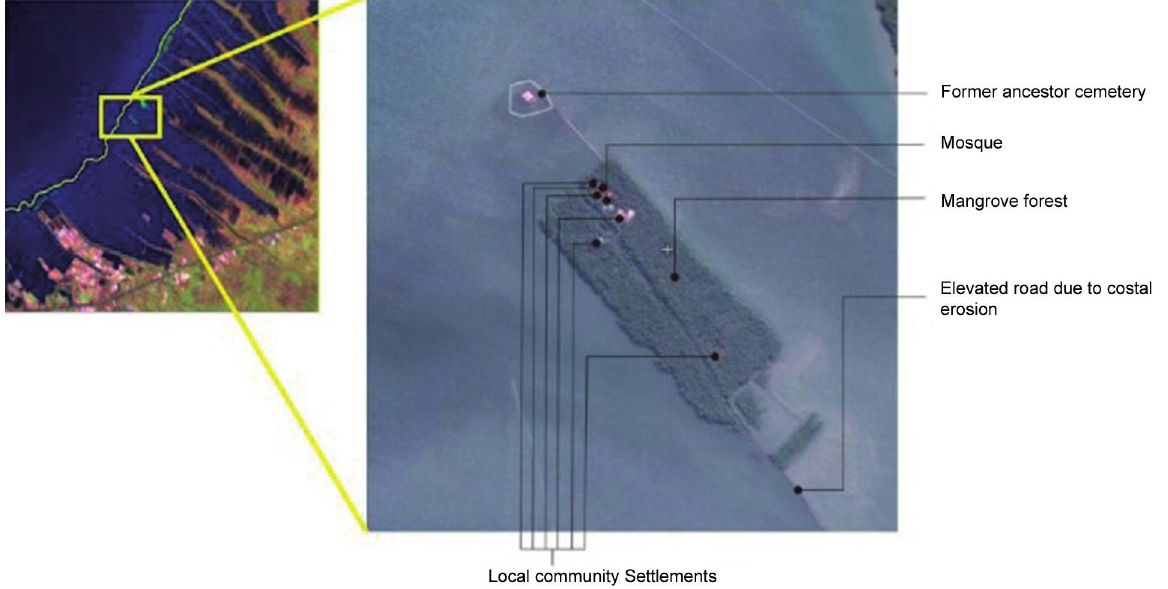
Fig. 2. Changes of shoreline due to the coastal erosion. (a) Landsat images in 1994 shown that the area still united as the mainland. (b) Landsat images in 2006 shown the study location is separated from the mainland.